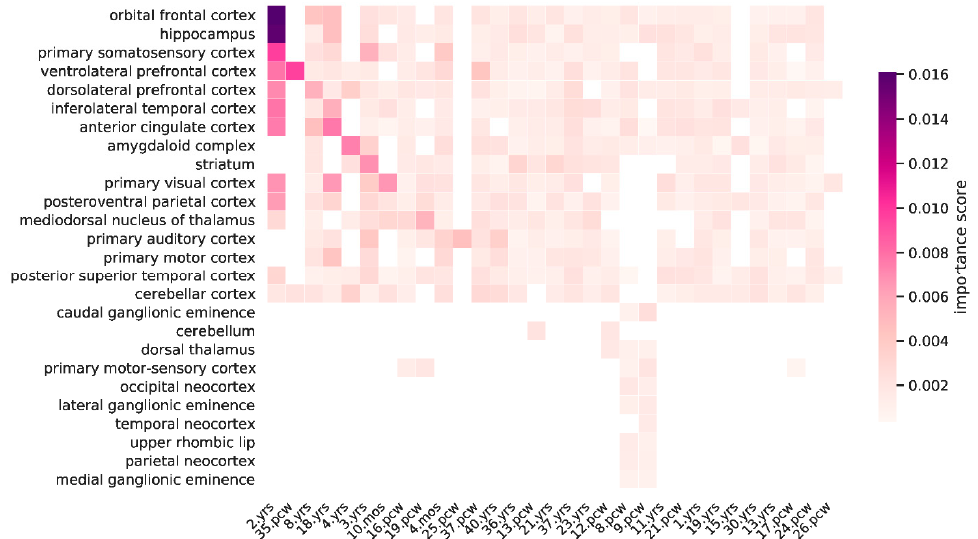
Figure 3. Visualization of the RF-based importance scores for the developmental brain gene expression features. The expression features with no importance score were excluded, and the importance scores of expression features in the same developmental time point and tissue type were averaged. The labels on the x-axis and y-axis have been arranged in descending orders based on the importance ranks of developmental time points and brain tissue types, respectively (pcw: post conception week; mos: months; yrs: years).